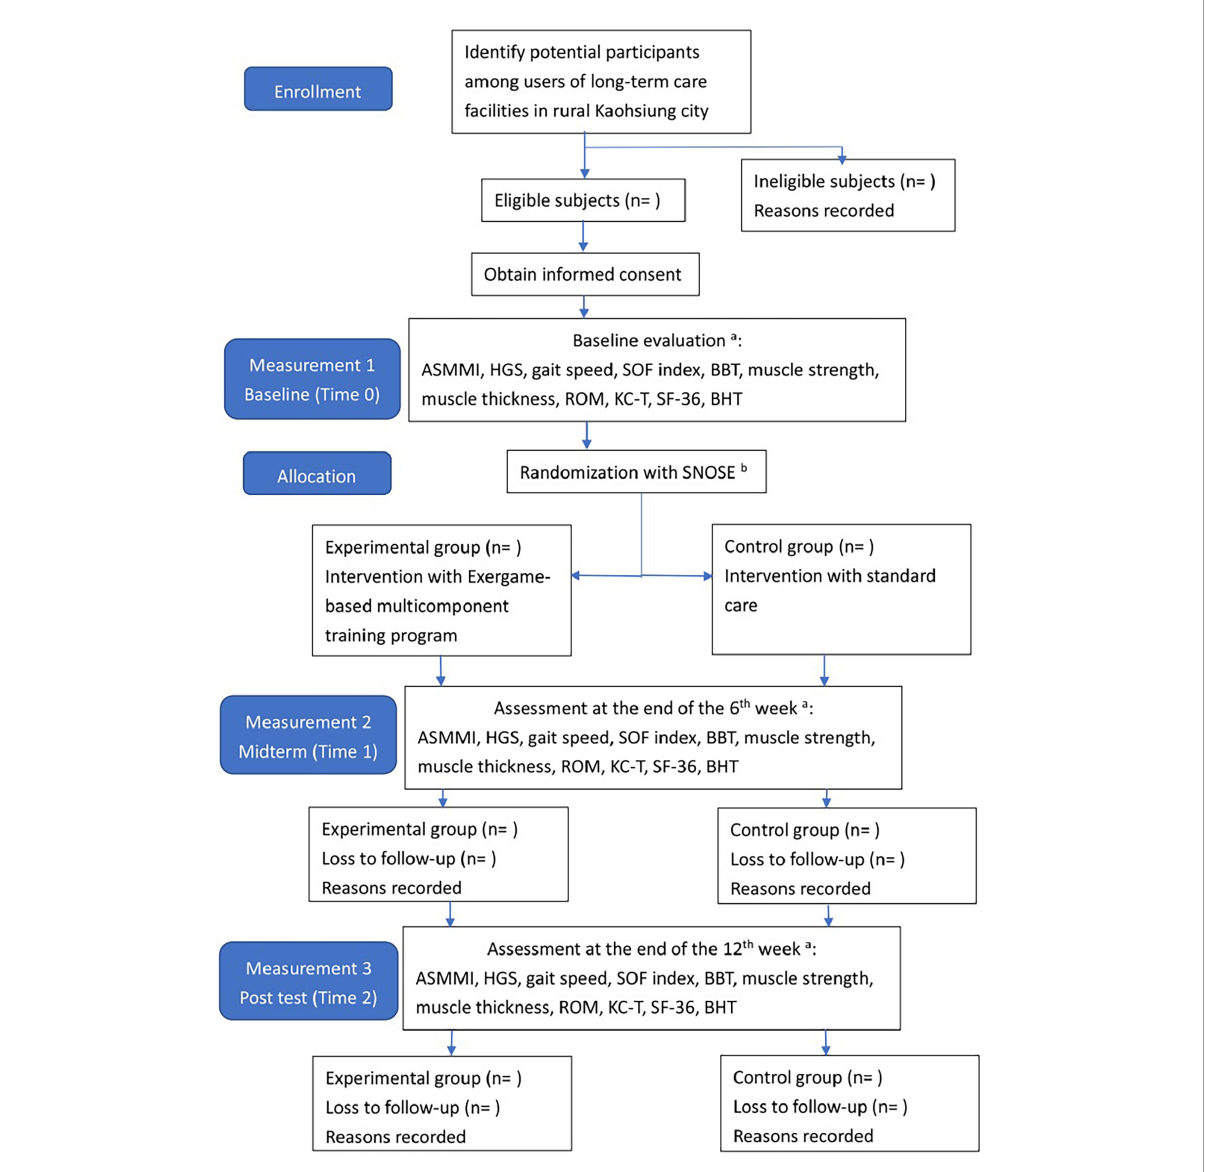
FIGURE1 The flowchart of the participant inclusion and data collection process. a See Table 1 ; b sequentially numbered, opaque, and sealed envelopes. ASMMI, appendicular skeletal muscle mass index; HGS, handgrip strength; SOF index, study of osteoporosis index; BBT, box and block test; ROM, range of motion; KC-T, Kihon checklist Taiwan version; SF-36, short form 36 questionnaire; BHT, brain health